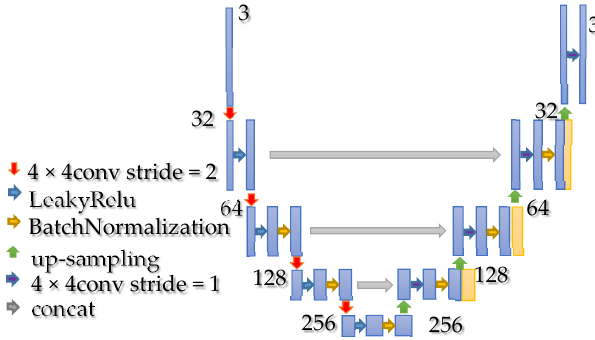
Figure 4. Architecture of U-Net.